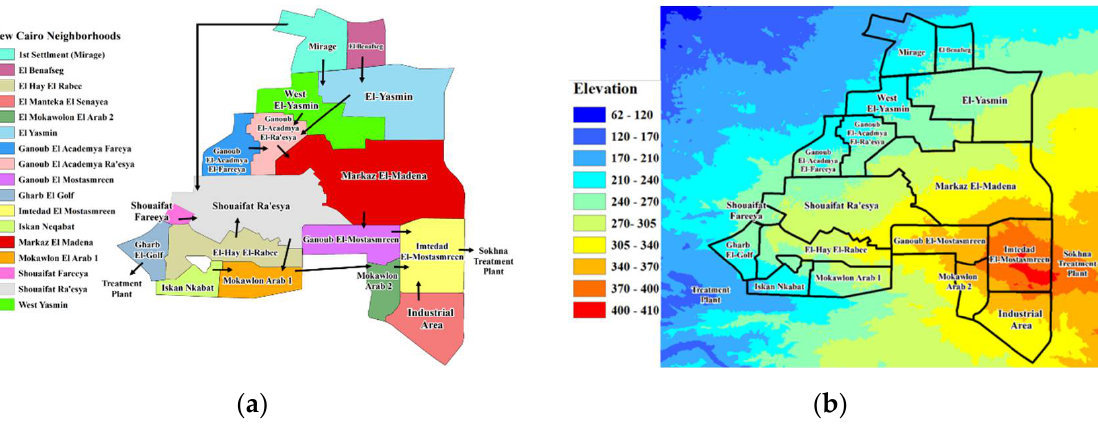
Figure 11. ( a ) Pumping stations schematic plan for New Cairo's districts showing their discharge destinations; ( b ) elevation map of New Cairo